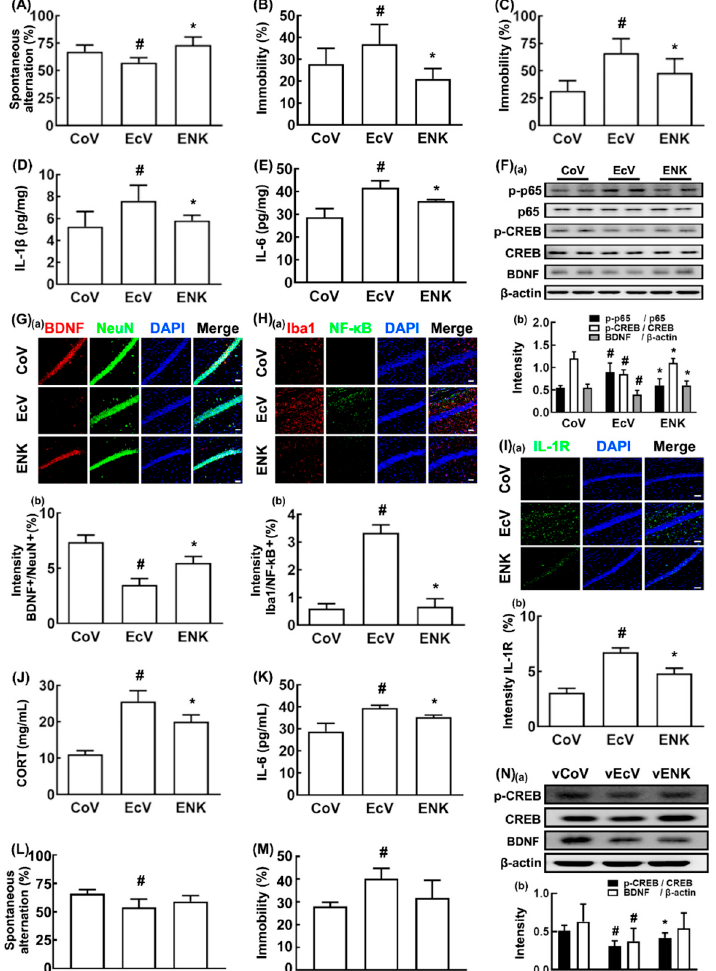
Figure 3. NK109 alleviated K1-induced cognitive impairment and depression in the mice. ( A ) E ff ect on cognitive impairment in the Y-maze task. E ff ect on depressive behaviors in the TST ( B ) and forced swimming test (FST) ( C ). E ff ect on the hippocampal IL-1 β ( D ) and IL-6 levels ( E , F ) E ff ect on the hippocampal BDNF expression and NF- κ B activation ( a ) and their intensities ( b ). E ff ect on the hippocampal BDNF + / NeuN + (( G ): ( a ) Confocal microscope photo; ( b ) their intensities), NF- κ B + / Iba1 + (( H ): ( a ) Confocal microscope photo; ( b ) their intensities), and IL-1R + cell (( I ): ( a ) Confocal microscope photo; ( b ) their intensities) populations. E ff ect on the blood corticosterone ( J ) and IL-6 levels ( K ), assessed by ELISA. E ff ect on cognitive impairment in the Y-maze task ( L ) and depressive behaviors in the TST ( M ) and hippocampal BDNF expression and cAMP-response-element-binding protein (CREB) phosphorylation (( N ): ( a ) Immunoblotting photo; ( b ) their intensities). The vehicle-treated group in Escherichia coli K1-treated mice (EcV), vehicle-treated group in Escherichia coli K1-treated mice with vagotomy (vEcV), NK109-treated group in Escherichia coli -treated mice (ENK), NK109-treated in Escherichia coli K1-treated mice with vagotomy (vENK) were orally gavaged with the K1 (1 × 10 9 CFUs / mouse / day). The CoV and vCoV groups were treated with the vehicle instead of the K1 suspension. From the next day, the ENK and vENK groups were orally gavaged with NK109 (1 × 10 9 CFUs / mouse / day). The vehicle-treated in mice (CoV), vehicle-treated in sham mice (vCoV), vehicle-treated in Escherichia coli K1-treated mice (EcK), vehicle-treated in Escherichia coli K1-treated mice with vagotomy (vEcK) were orally gavaged with the vehicle. ( A – K ) Experiments for the CoV, EcV, and ENK groups were performed in the mice without vagotomy. Experiments for the vCoV, vEcV, and vENK groups were performed in the mice with vagotomy. Data values are described as mean ± SD ( n = 6). Means with same letters are not significantly di ff erent ( p < 0.05). # p < 0.05 vs. CoV or vCoV. * p < 0.05 vs. EcV or vEcV. CORT,